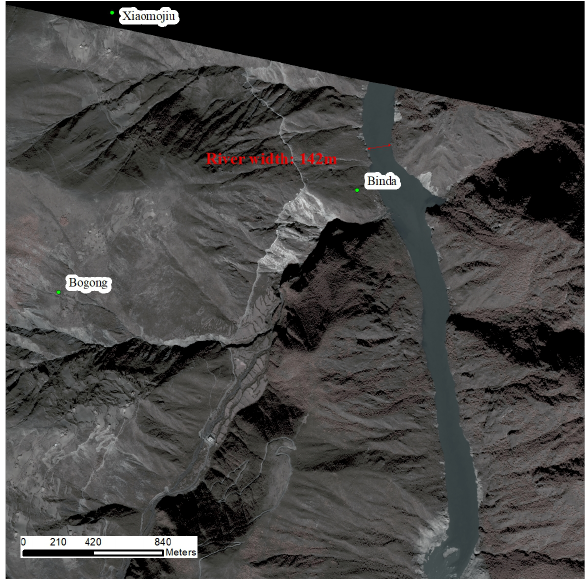
Figure 4. Landslide lake pre-disaster GF-2 image